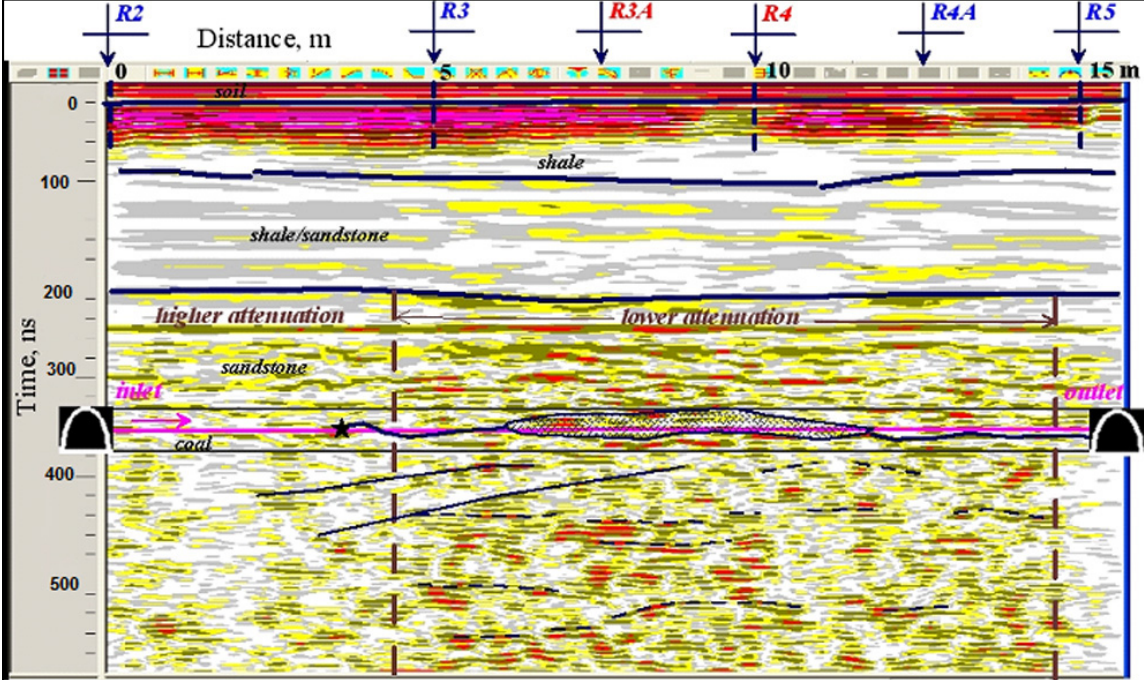
Figure 6. GPR monitoring section of the cavity of the UCG test in Barbara, Poland (from [29]).